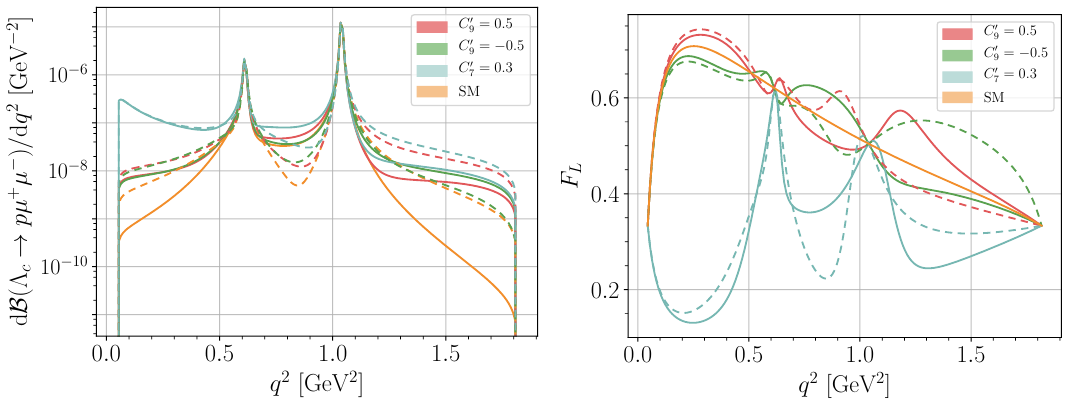
Figure 5 . The differential branching fraction (left) and fraction of longitudinally polarized dimuons (right) based on resonant SM contributions (orange) and in NP scenarios with C 0 = 0 . 3 . Strong phases are fixed to δ C 0 7 curves). Unlike in d B /dq 2 , uncertainties due to strong phases cancel in F for